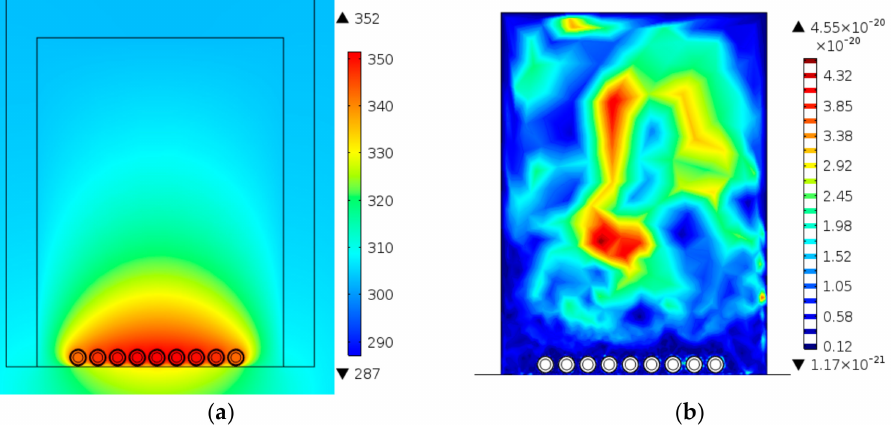
Figure 8. Temperature field and velocity distribution with 420 A current. ( a ) Temperature field distribution (Unit: K). ( b ) Air flow field velocity distribution (unit: m /